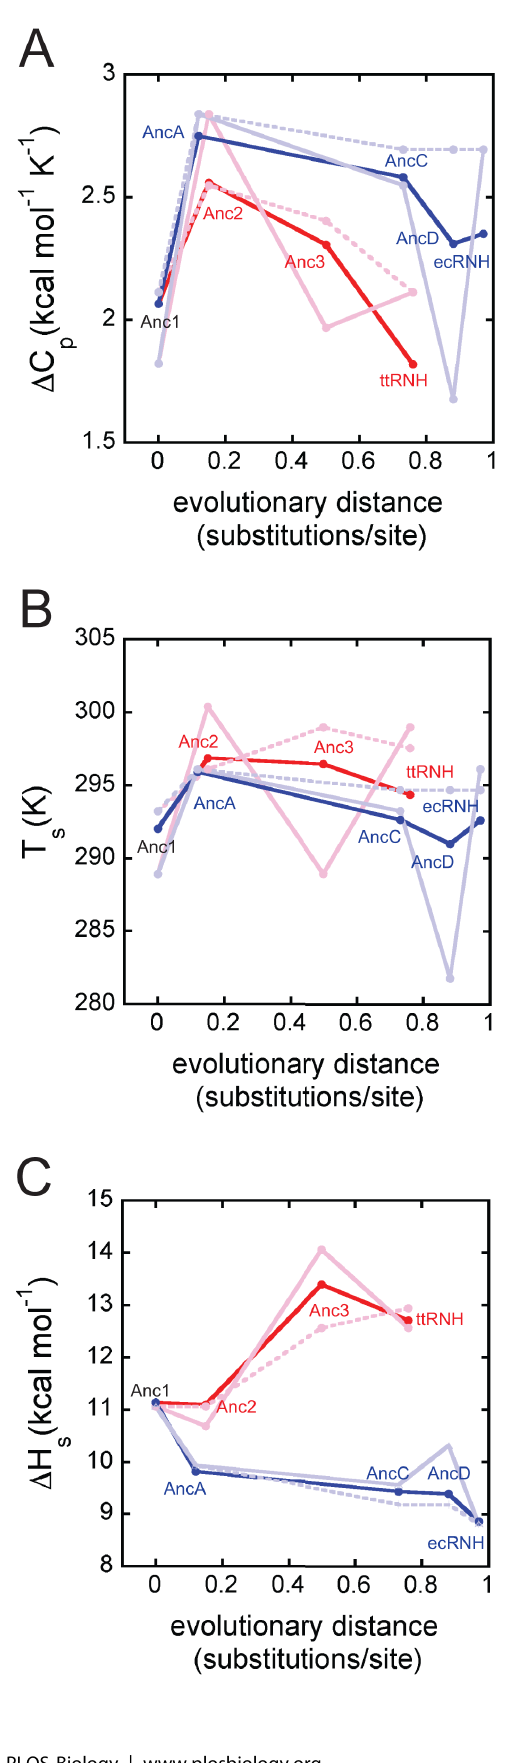
Figure 6. The thermodynamic underpinnings of RNH T m fluctuated over evolutionary time. Estimated D C p (A), T s (B), and D H s (C) over the evolution of ttRNH (red) and ecRNH (blue). Maximum likelihood path is shown in bold. The shortest (dashed line) and longest (solid line) plausible alternate trajectories (95% confidence interval) are shown in faded blue and pink. See also Dataset